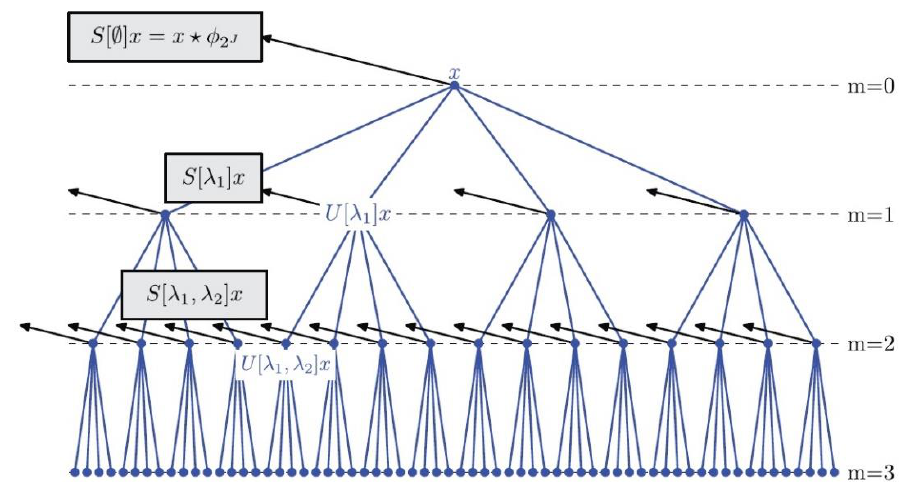
Figure 1. Structure of a wavelet scattering network which computes the windowed scattering trans- form. Reprinted with permission from ref. [27]. Copyright © 2013 IEEE.